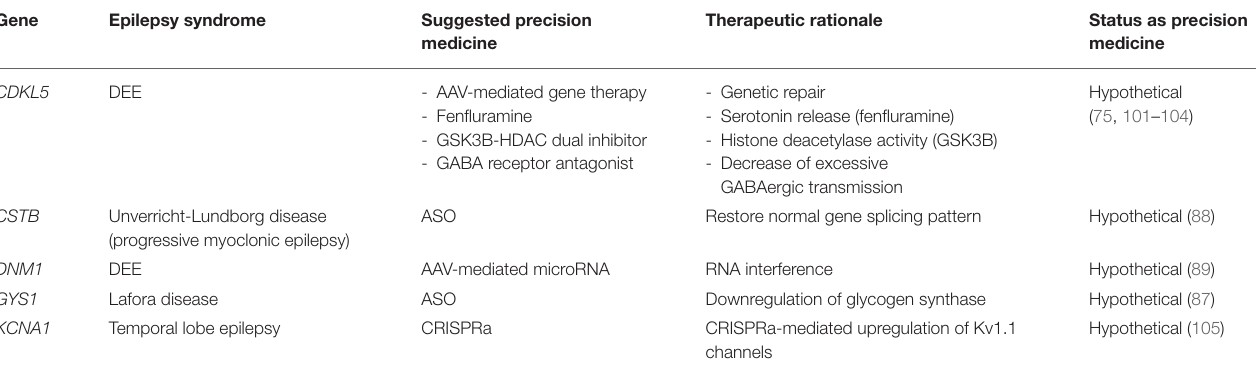
TABLE 6 | Gene therapies for monogenic